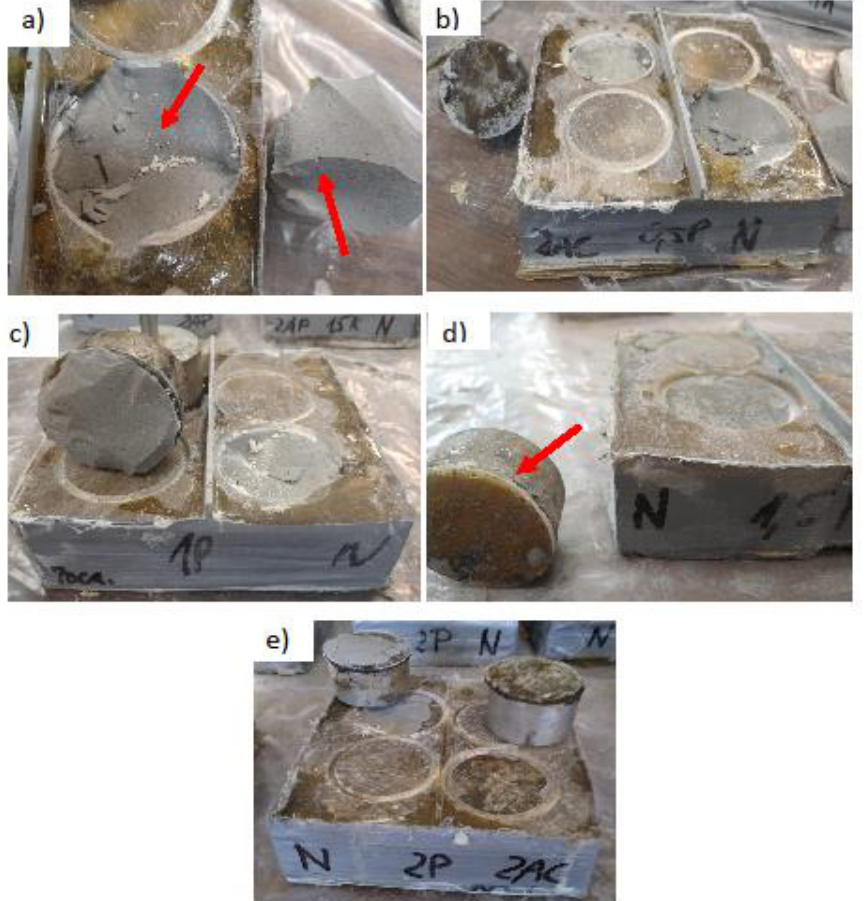
Figure 13. Photos of epoxy resin coating samples after detachment: ( a ) without additive (cohesive failure), ( b ) 0.5 wt % of the additive (adhesive failure), ( c ) 1 wt % (cohesive failure), ( d ) 1.5 wt % (adhesive failure), ( e ) 2 wt % (adhesive failure).